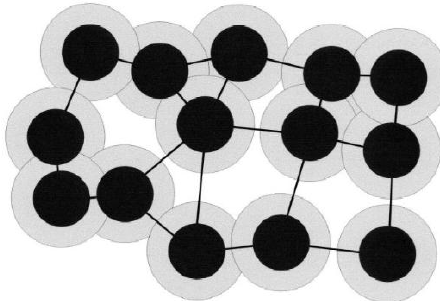
Figure 7. Schematic demonstration of the tunneling model in carbon/polymer composite